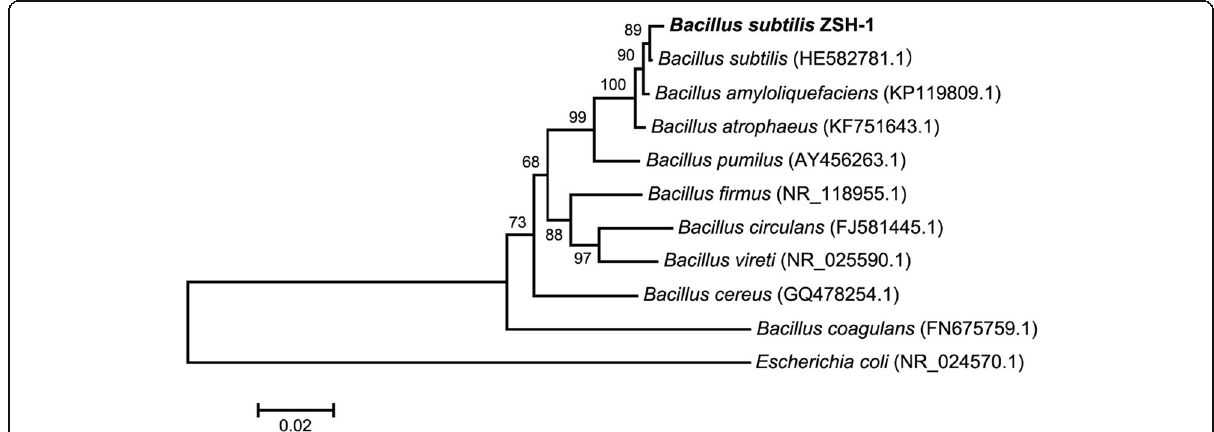
Fig. 1 Phylogenetic tree of strain ZSH-1 based on 16S rRNA sequence